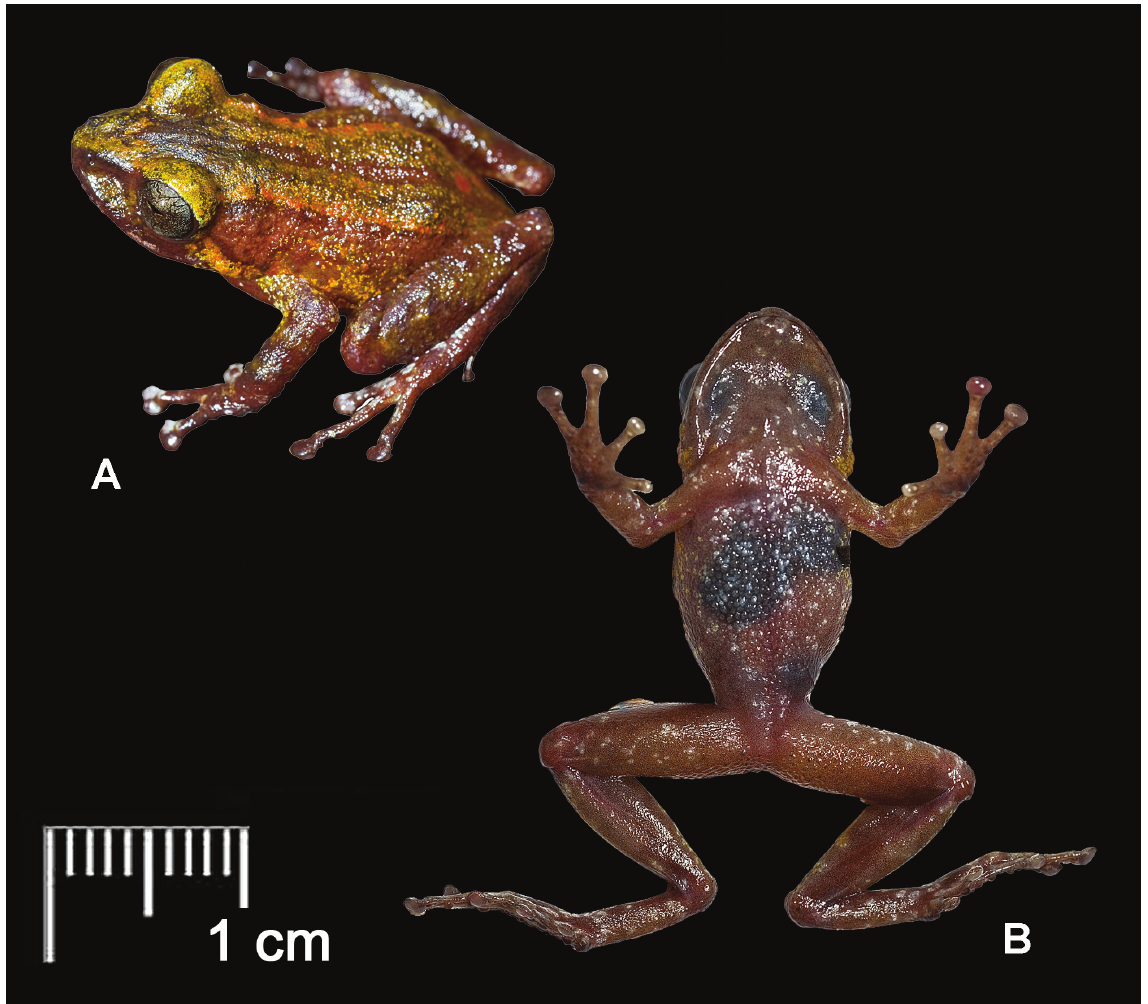
Fig. 8. Pristimantis imthurni sp. nov. in life. A . Dorsolateral view of the ♂ holotype (IRSNB 4165). B . Ventral view of the same specimen. Photographs by the